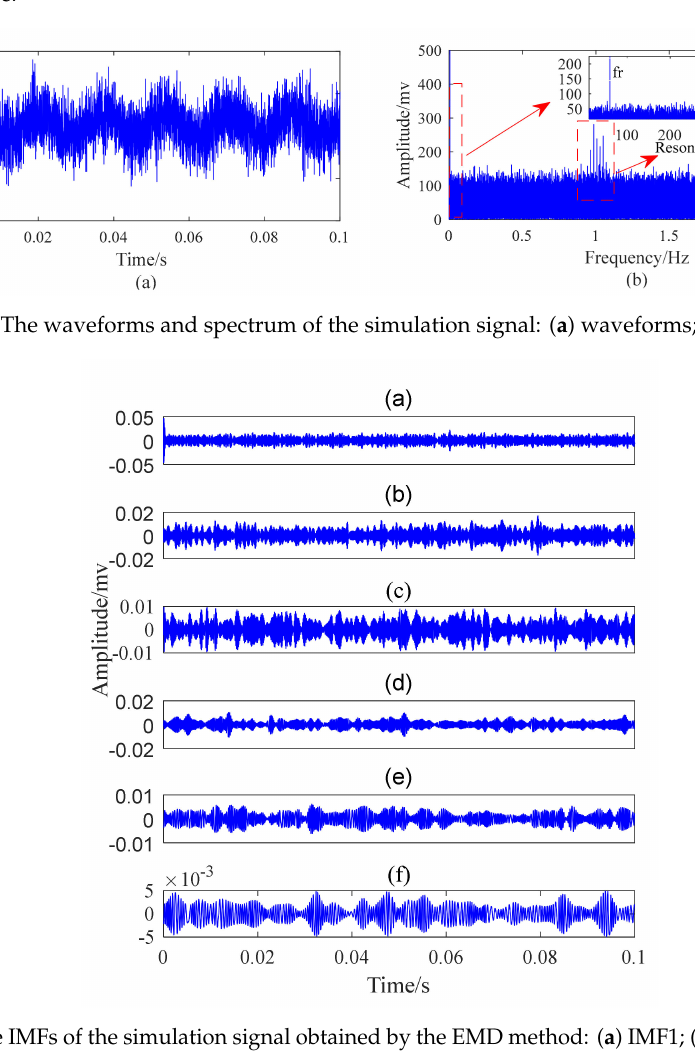
Figure 2. The components of the simulation signal: ( a ) impact signal; ( b ) trend term; ( c ) white noise; ( d ) color noise.